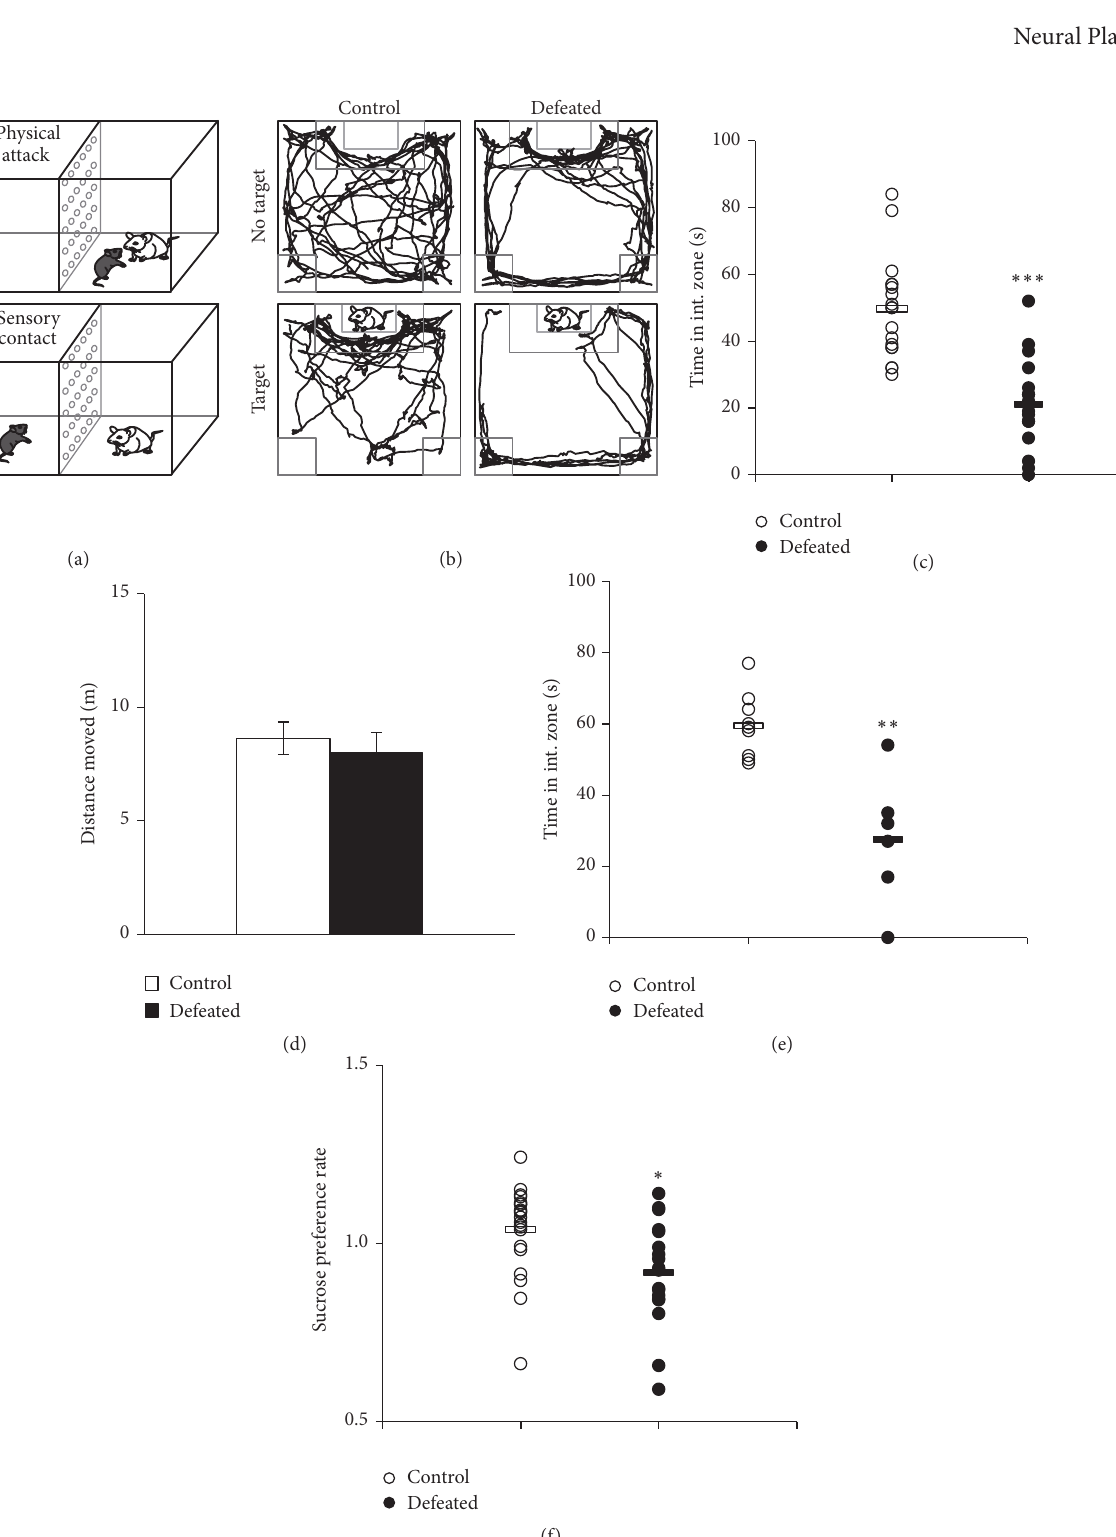
Figure 1: Effects of chronic social defeat stress on mice behaviors. (a) Chronic social defeat stress (CSDS) paradigm. Thy1- YFP-H line mice are repeatedly subjected to social defeat bouts by different stronger and aggressive CD-1 mice. Even after each 10min defeat bout, the defeated mouse is exposed to persistent psychological stress from sensory interaction with a CD-1 mouse. (b) Social interaction test. Video-tracking data in the whole arena from control and defeated animals in the absence and presence of a social target. (c) Averaged time spent in interaction zone of control ( 𝑛 = 18 ) and defeated ( 𝑛 = 18 ) mice with a social target after a 10-day CSDS. [Student’s 𝑡 -test: ∗∗∗ 𝑃 < 0.001 .] (d) Total locomotion of control ( 𝑛 = 13 ) and defeated ( 𝑛 = 12 ) mice in the whole arena during 150 s with a social target after a 10-day CSDS. [Student’s 𝑡 -test: 𝑃 = 0.66 .] (e) Averaged time spent in interaction zone of control ( 𝑛 = 9 ) and defeated ( 𝑛 = 6 ) mice with a social target after a 10-day recovery. [Student’s 𝑡 -test: ∗∗ 𝑃 < 0.01 .] (f) Averaged sucrose preference rate of control ( 𝑛 = 19 ) and defeated ( 𝑛 = 18 ) mice [Student’s 𝑡 -test: ∗ 𝑃 < 0.05